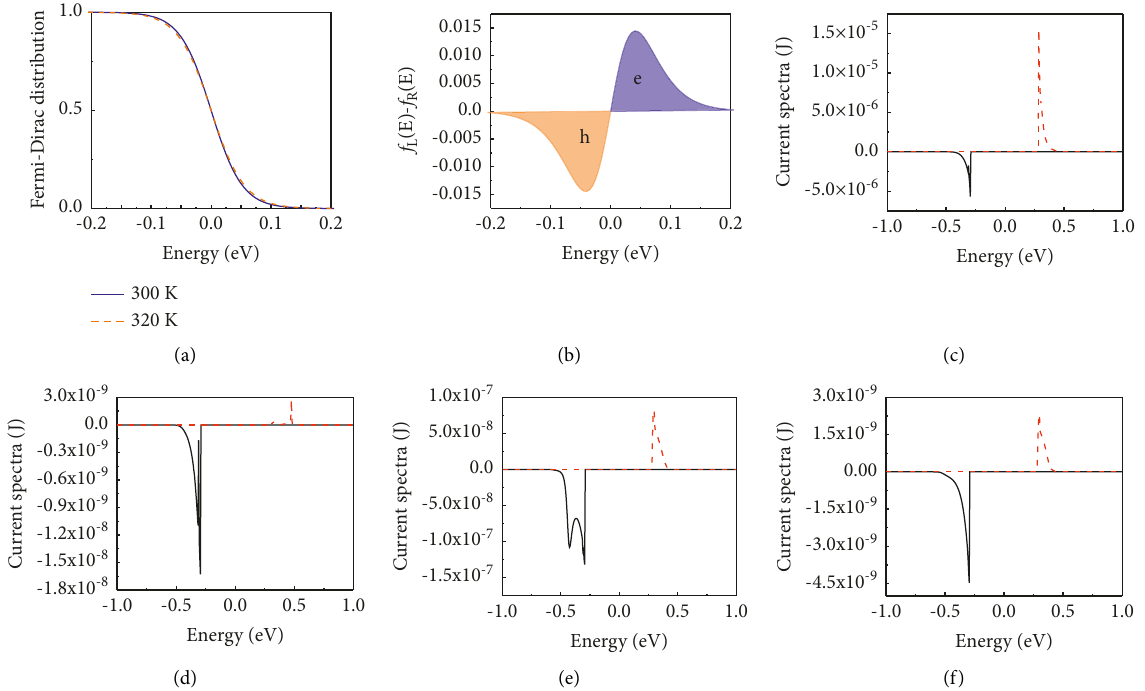
Figure 3: (a) The thermal spin device’s Fermi distribution of the T The spin-related current spectra at state, and (f) R CH 2 , open (cid:31)